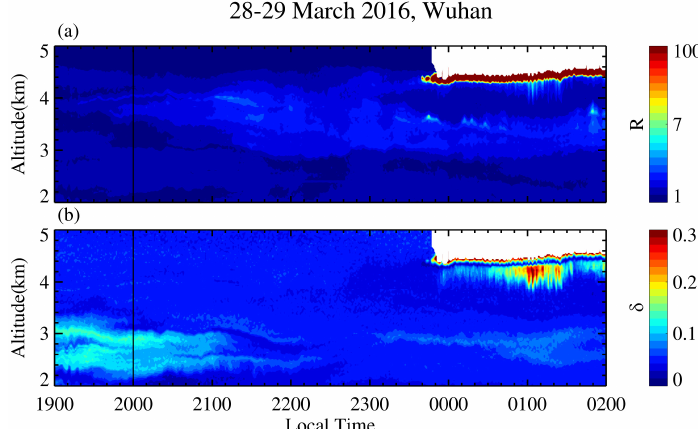
Figure 5. Time-height contour plots of backscatter ratio R ( a ), volume depolarization ratio δ ( b ) Figure5. Time-heightcontourplotsofbackscatterratioR( a ), volumedepolarizationratio δ ( b )measured measured by our 532-nm polarization lidar (1-min/30-m resolution) from 1900 LT on 28 March to by our 532-nm polarization lidar (1-min / 30-m resolution) from 1900 LT on 28 March to 0200 LT on 29 March 2016. The water vapor mixing ratio was not available because the Raman Lidar was on